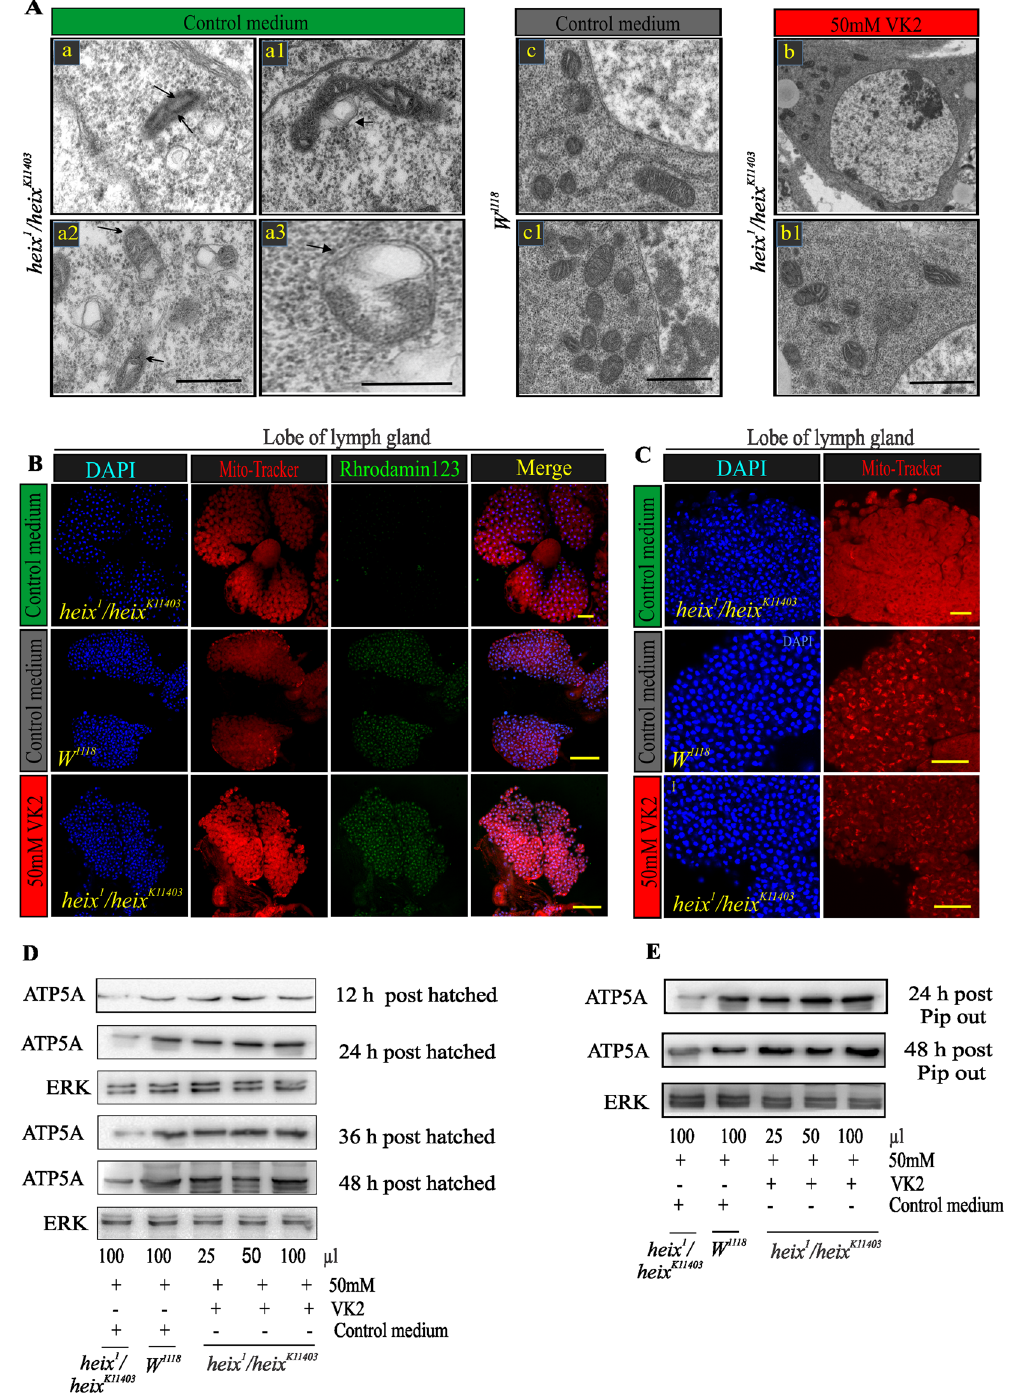
Figure 5. Vitamin K2 restores mitochondrial structure and membrane potential. ( A ) Transmission electron microscopy (TEM) images of lymph gland cells, heix mutant exhibits enlarged mitochondria with broken cristae, there are multiple swelling mitochondria of different size and several degrees of cristae disarrangement (arrow), higher magnification of a mitochondrion with electron-lucent matrix and subtotal Cristo lysis beside presence of amorphous metrical densities (arrows). Note the dilated mitochondrial matrix occupied by lipoid-like material (arrows). Method of staining: Uranile acetate/Lead citrate. Bar: 2 µ m. ( B ) More negative mitochondrial membrane potential ΔΨ m with VK2 treatment. DAPI stain (blue) and Rhodamin 123 (green). ( C ) Confocal microscopy of lymph gland labeled with Mito-Tracker showed mitochondrial morphological defects. DAPI stain (blue) and Mito-Tracker CMXROS (red). ( D ) Western blot analysis of recently hatched larvae (12, 24, 36 and 48 hrs post hatching) reared on vitamin K2 media, showed gradual increase in expression of ATP production. ( E ) Western blot analysis of pupal pip out flies (24 and 48 hrs post pupal pip out),